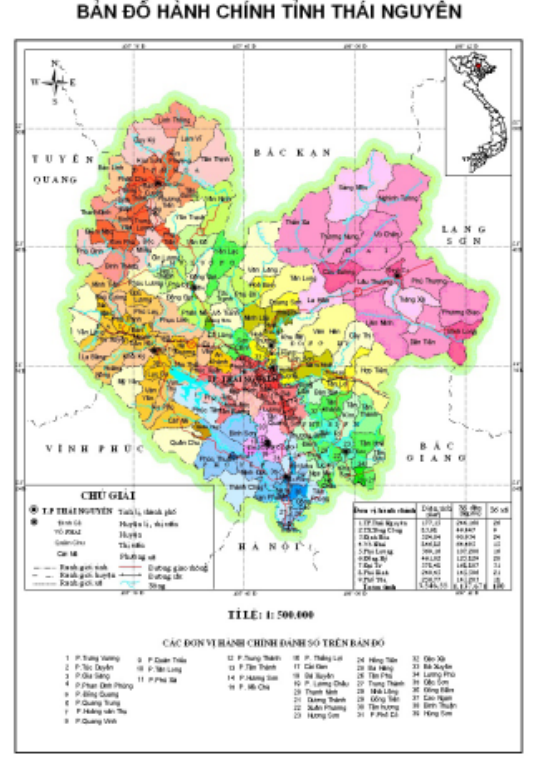
Figure 1: Administration E.Atlas of Thai Nguyen